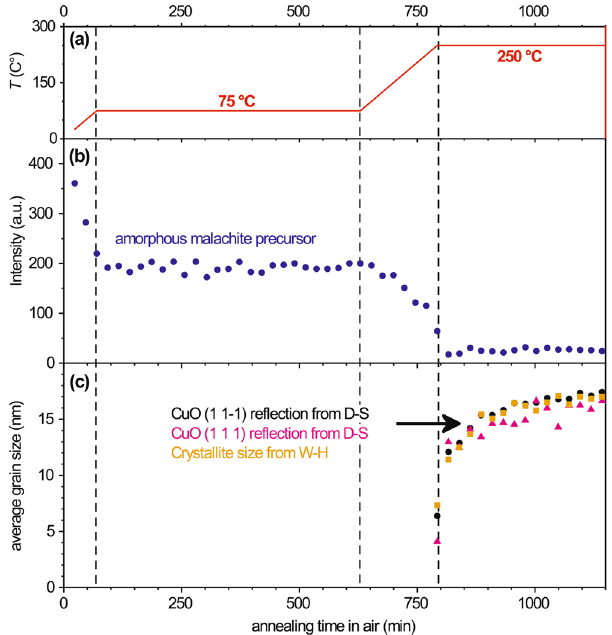
Figure 3. In-situ XRD analysis of the calcination process of the amorphous copper-carbonate-hydroxide precursor phase into CuO upon annealing in air. ( a ) Temperature profile. ( b ) Intensity of the (102) reflection over time (temperature). ( c ) Size of the coherent scattering domains of CuO as extracted from the CuO (11-1) and CuO (111) reflections using either the Debye-Scherrer or the Williamson-Hall